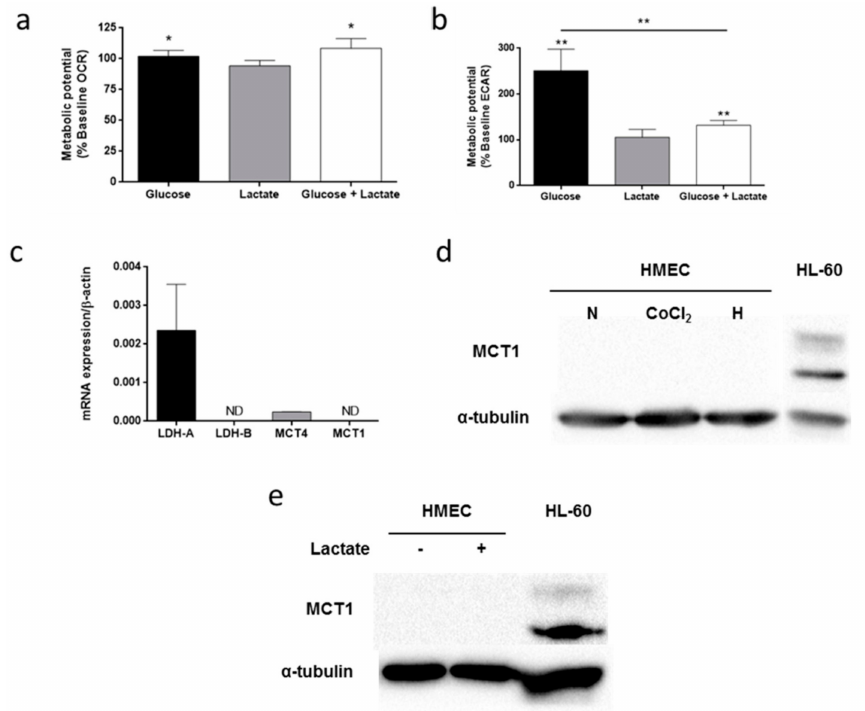
Figure 8. Lactate metabolism in HMEC. ( a ) Oxygen consumption rate (OCR) and ( b ) extracellular acidification rate (ECAR) were measured in the presence of 5 mM glucose and / or 10 mM lactate. ( c ) mRNA expression of LDH-A, LDH-B, MCT4 and MCT1. ( d ) MCT1 protein expression was determined under normoxia, 200 µ M CoCl 2 or 1% hypoxia. ( e ) MCT1 protein expression was determined in the presence or absence of 10 µ M lactate. HL-60 under normoxia were used as positive control. Data are expressed as means ± SD of three independent experiments. * p < 0.05, ** p < 0.01 versus no glucose or lactate available ( a , b ). ND: non